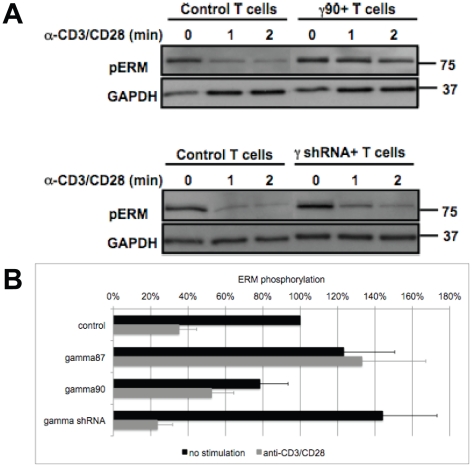
PIP5K overexpression interferes with ERM dephosphorylation.
A, B. 5C.C7 T cells were activated with α-CD3 and α-CD28 antibodies for 1 or 2 min upon manipulation of PIP5K expression as indicated. T cell extracts were blotted for phospho-Ezrin T567/Radixin T564/Moesin T558. Representative blots are given in (A). Phospho-ERM levels after two minutes of T cell activation are given with standard errors relative to those of T cell extracts from non-stimulated, non-transduced T cells in (B). Modest differences in ERM phosphorylation prior to T cell stimulation were not significant. Data from 3–10 independent experiments are given.